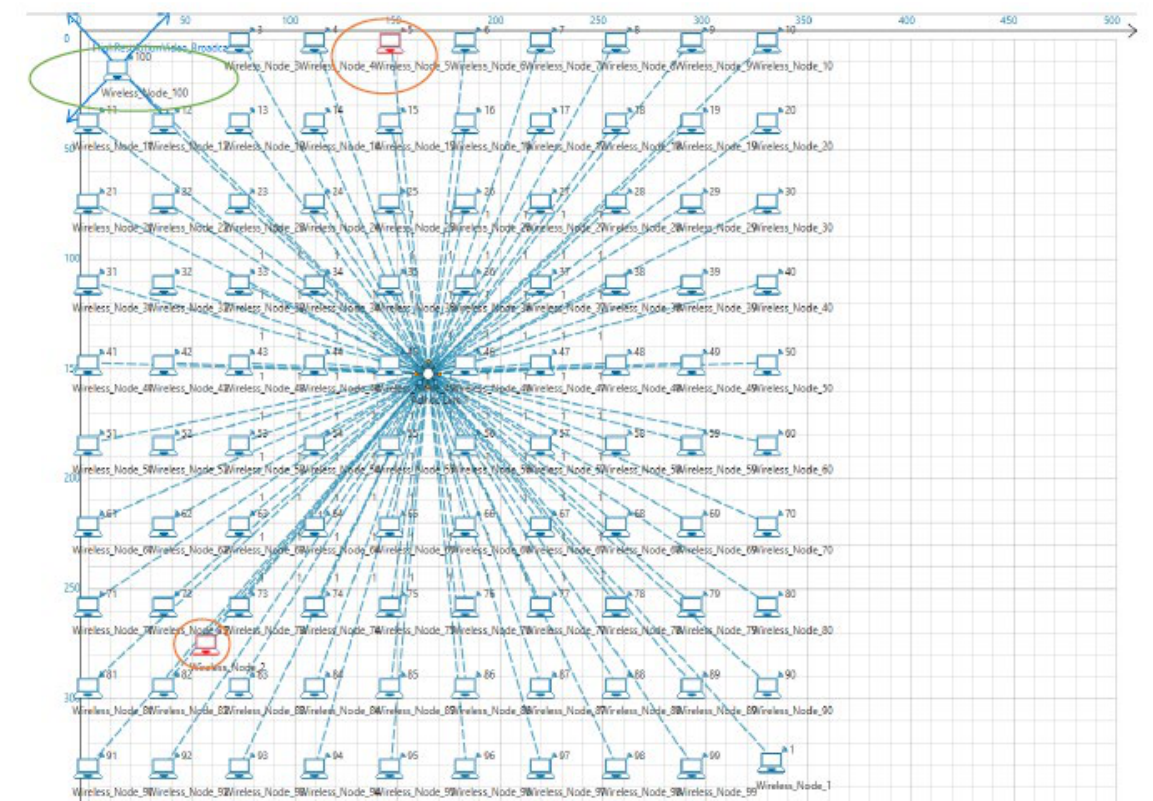
Figure 17. Network model of 100 nodes with two sinkhole nodes added.